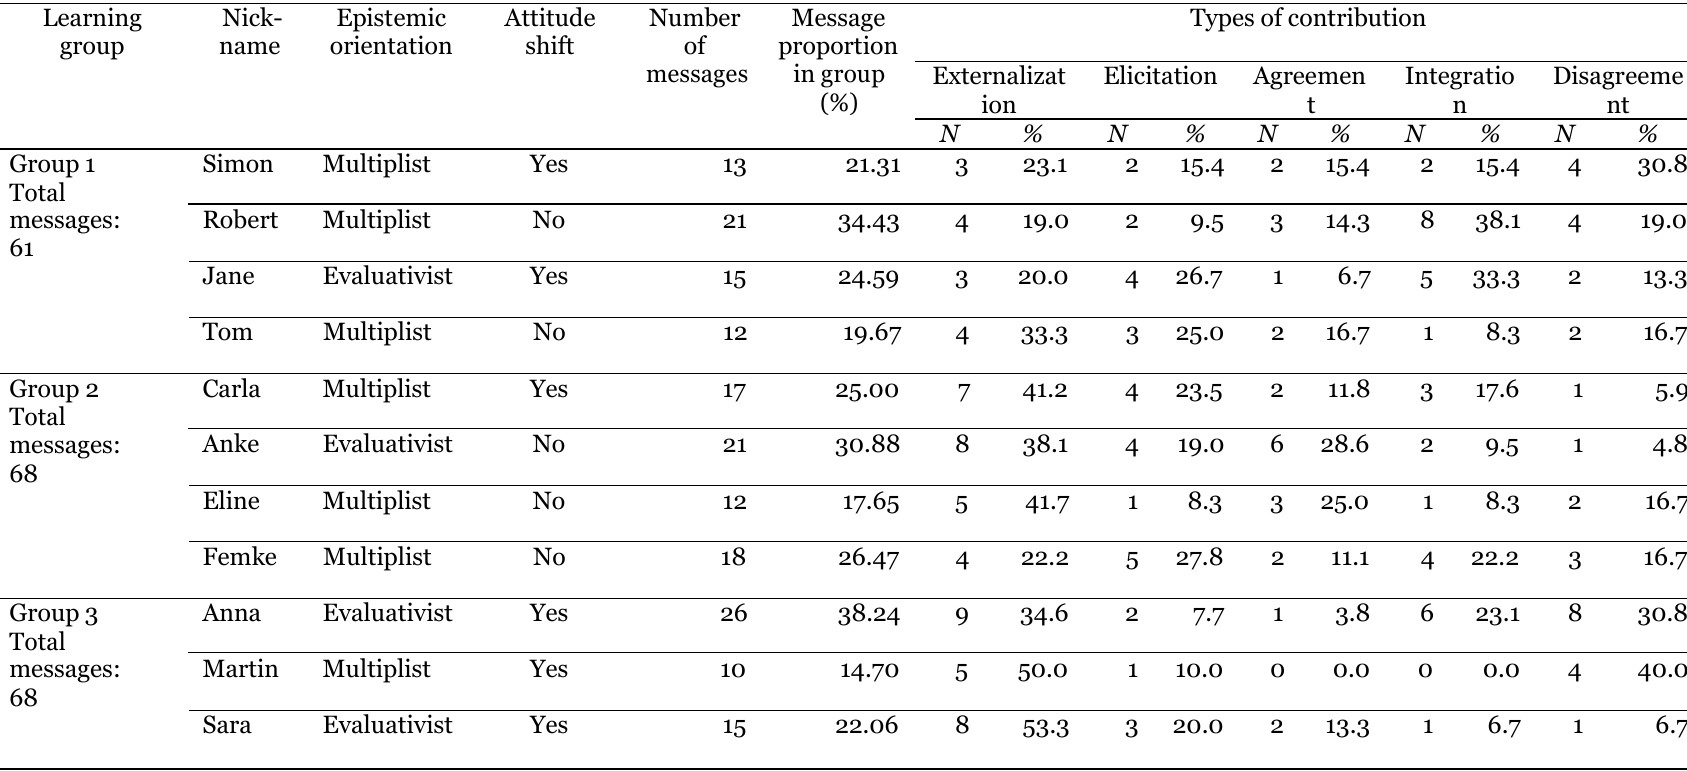
Table 1 Students’ Epistemic Orientation, Attitude Shift, Number of Messages, and Types of Contribution Learning